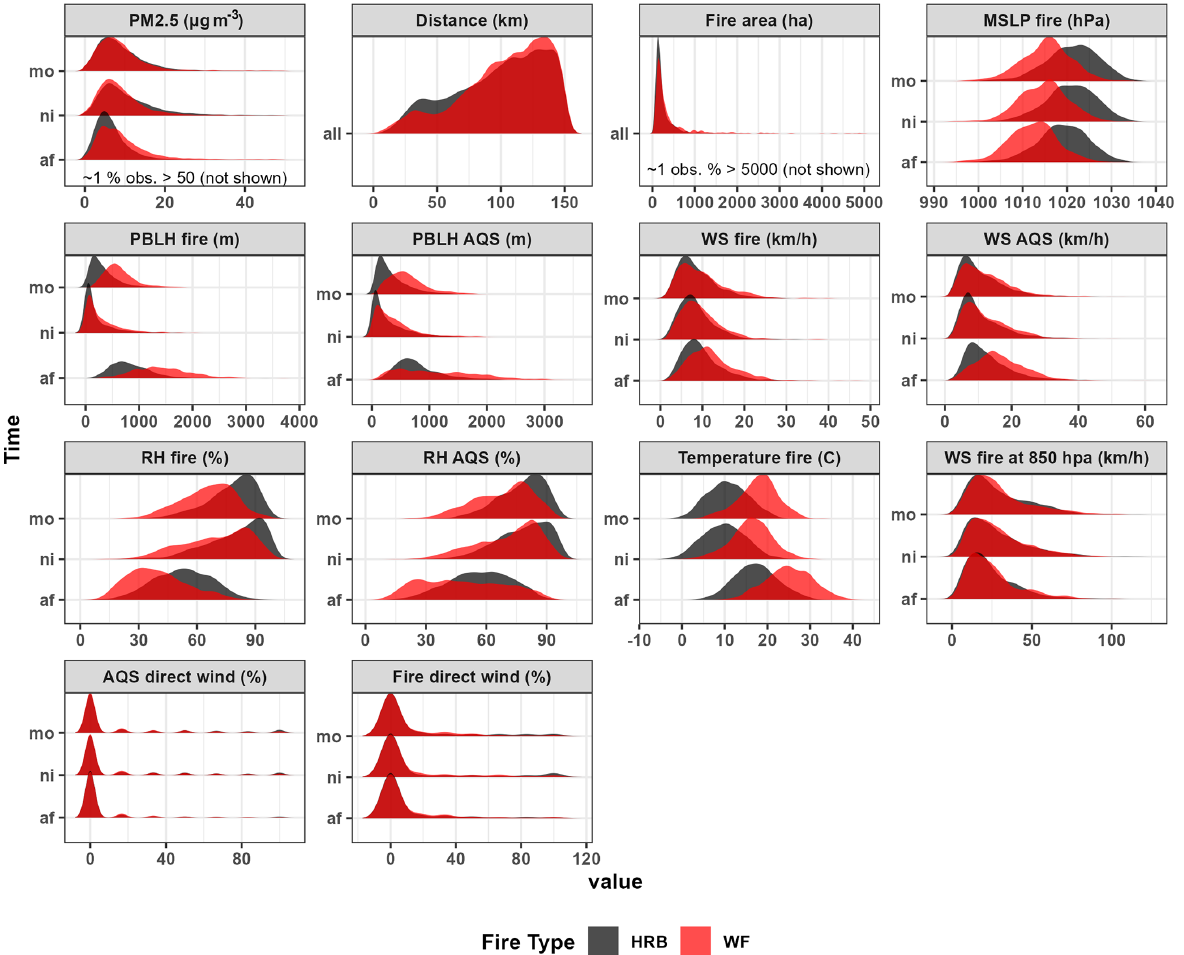
Figure 3. Distribution of PM 2 . 5 and predictor variables used in random forest modelling, excluding latitude, longitude, fire type and month. Distance and daily active fire area are daily variables, so they are identical for afternoon, night and morning model datasets. Distributions for at-fire variables are from unique fire–day combinations, at-AQS variable values are from unique AQS-day combinations. af, afternoon; ni, night; mo, morning; AQS, air quality station; RH, relative humidity; WS, wind speed; PBLH, planetary boundary layer height; MSLP, mean sea level